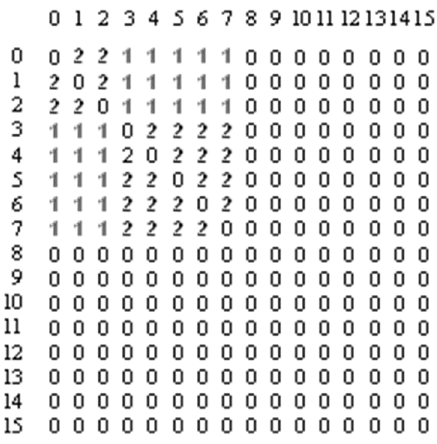
(2) The items in the matrix 𝑩 are symmetric distances between every pair of 𝑛